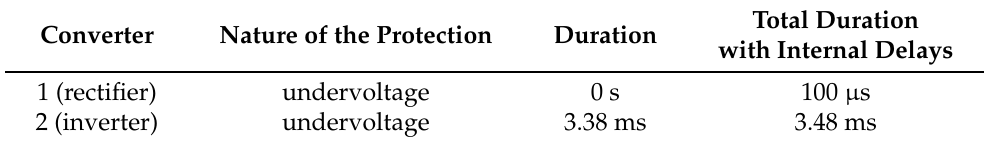
Table 6. Protection method that triggers for each converter with AC circuit-breakers Converter